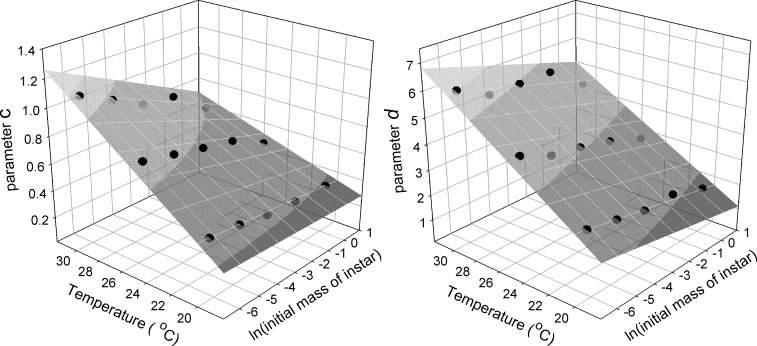
Dependence of Gompertz parameters on initial szie and temperature.Effect of initial size (natural log of mass) and temperature on the values of Gompertz parameters c (left panel) and d (right panel) in the wild-type strain. The coefficients for the regression are: for parameter c, using the natural logarithm of initial mass of an instar, k1 = 0.0824, k2 = 0.0344, k3 = -0.0049, k4 = -0.3330, r2 = 0.986, p<0.0001; for parameter d, k1 = -0.0157, k2 = 0.2899, k3 = -0.0068, k4 = -3.9937, r2 = 0.985, p<0.0001.